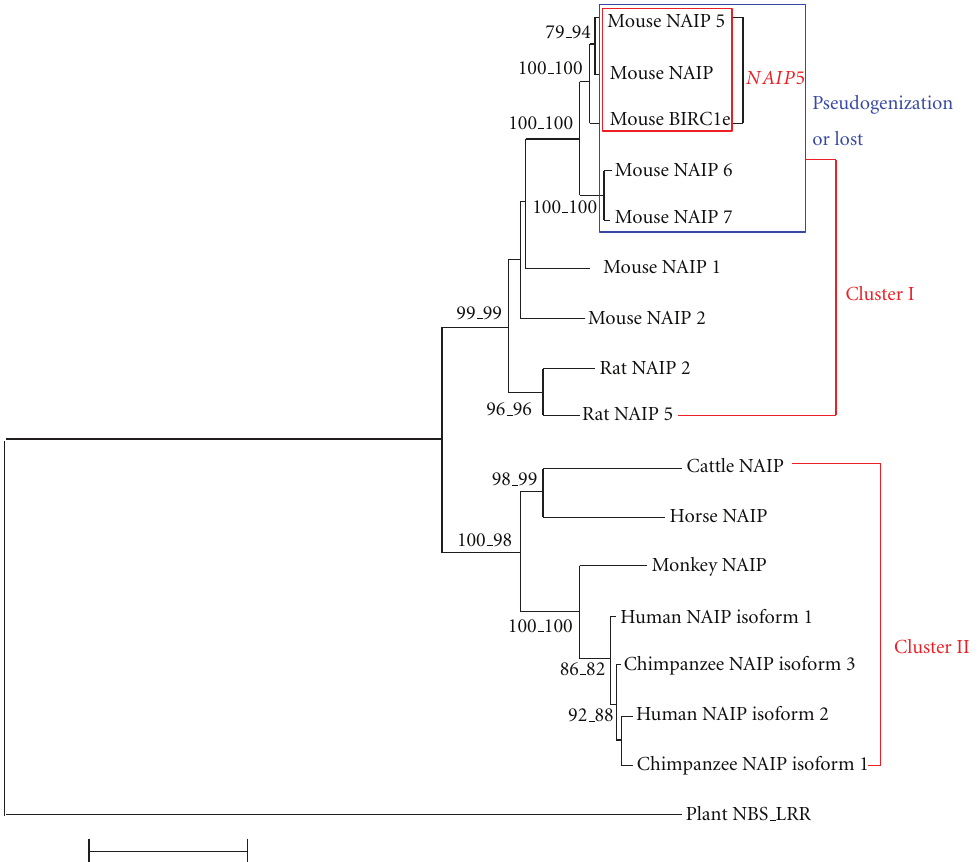
Figure 2: Phylogenetic tree of NAIPs reconstructed using two di ff erent methods (NJ and ME). A total of 16 NAIP protein sequences from seven mammalian species (cow, horse, human, chimpanzee, monkey, mouse, and rat) were included in the analysis. Bootstrap values are shown on the branches for the two di ff erent methods (following the order of the NJ and ME